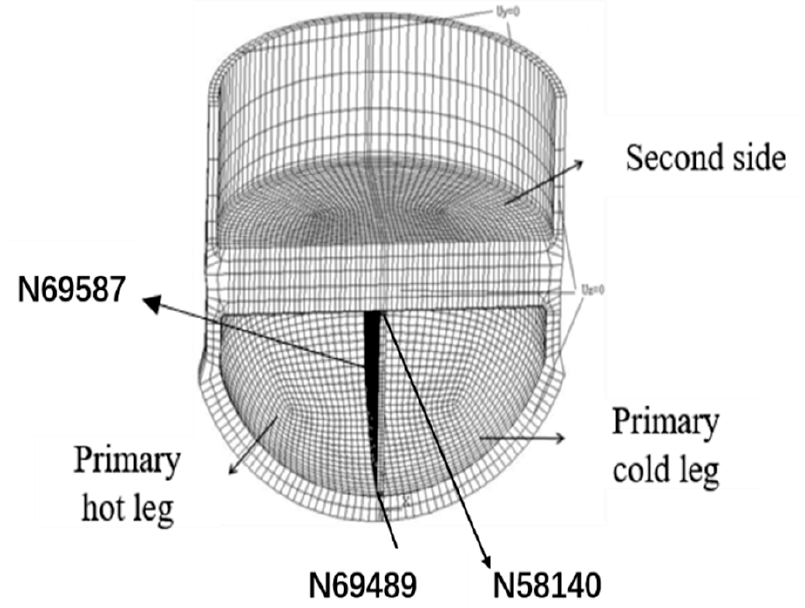
Figure 6. Finite element model and boundary conditions of the divider plate in the steam generator. The resulting interaction of the divider plate with the tube sheet and channel head is the major source of stress in the plate. The pressure causes the dilation of the channel head, which stretches the divider plate in turn. Another source of divider plate stress is the pressure differential across it. Thermal stresses are induced partly in the divider plate by the mismatch between the coefficients of the thermal expansions of the Inconel divider plate and the carbon steel channel head and tube sheet. The temperature difference due to the hot leg and cold leg is also another main source. The primary temperature and pressure transients used in fatigue analysis are the same as those in Section